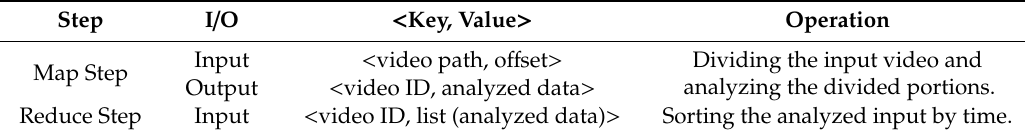
Table 1. The key-value pairs used for the MapReduce Analyzer.